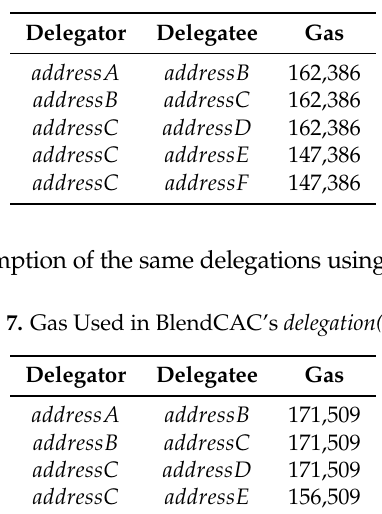
Table 6. Gas Used in delegation() ABI.